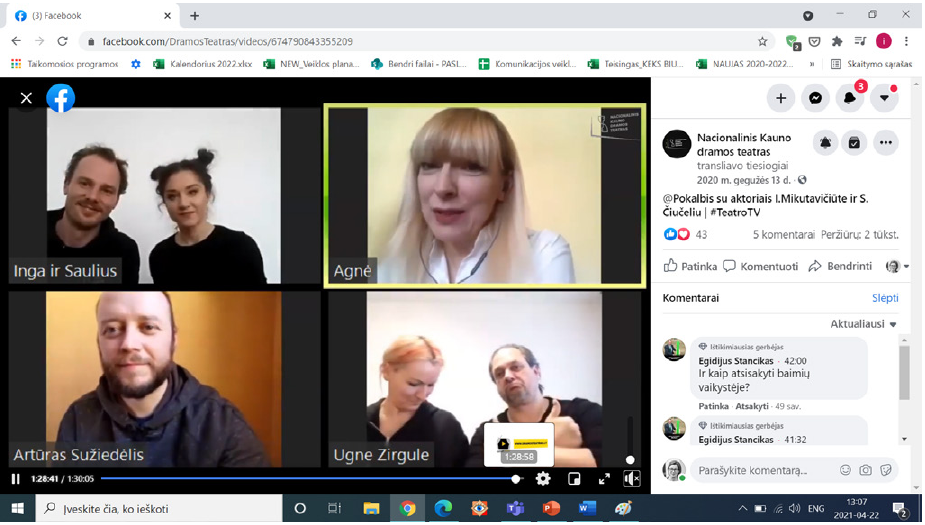
Figure 3. Online discussion after the performance Runaway Hare . Screenshot in April, 2021 (source: created by